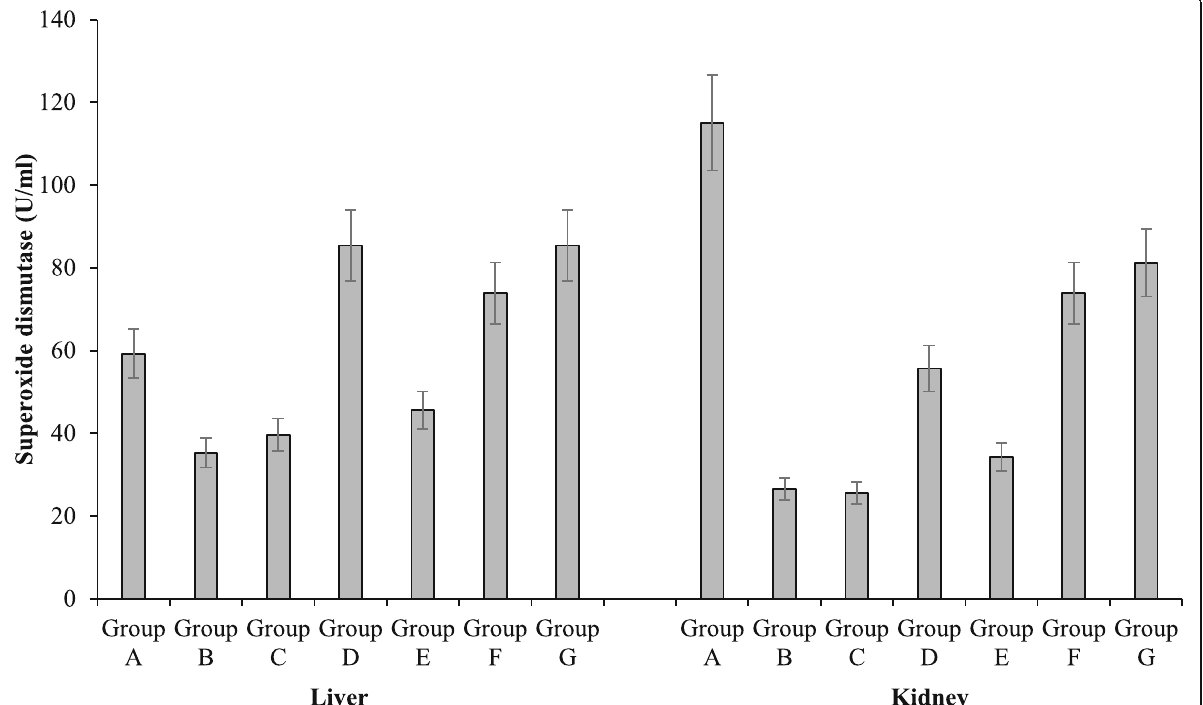
Fig. 2 Effects of aqueous extract of fruit pulp of A. digitata on the mean Superoxide dismutase (SOD) antioxidative activities and oxidative stress in the organs of albino rats in the different